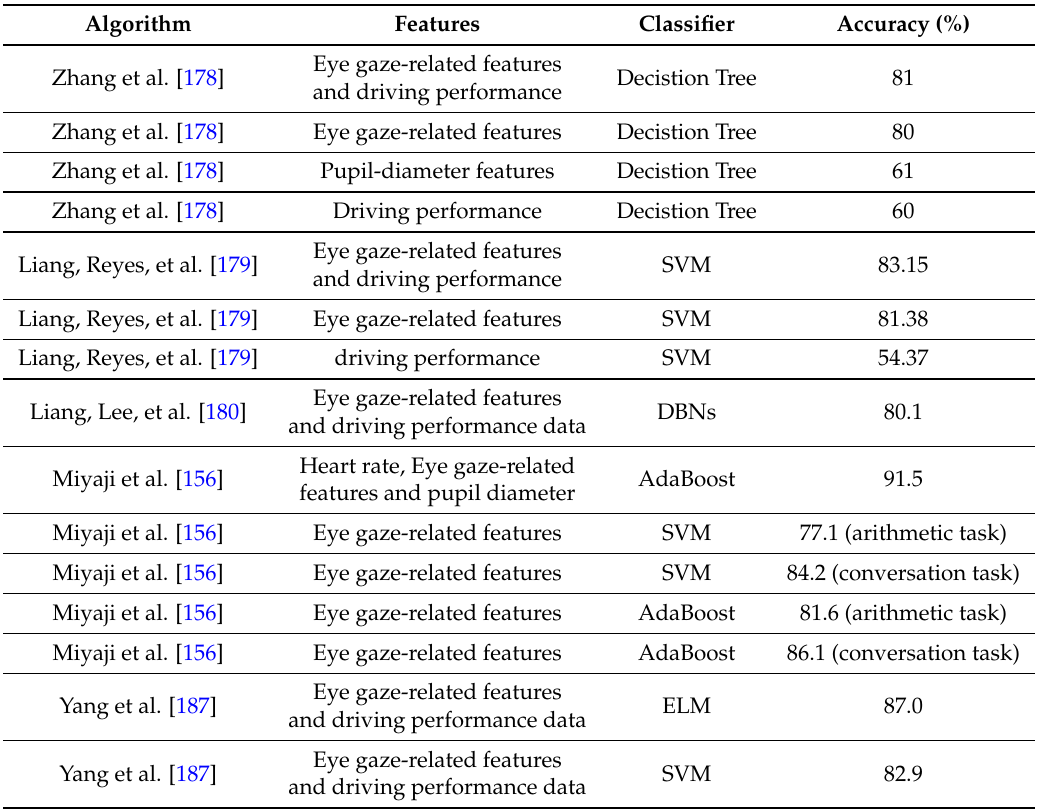
Table 6. Supervised algorithms for cognitive distraction